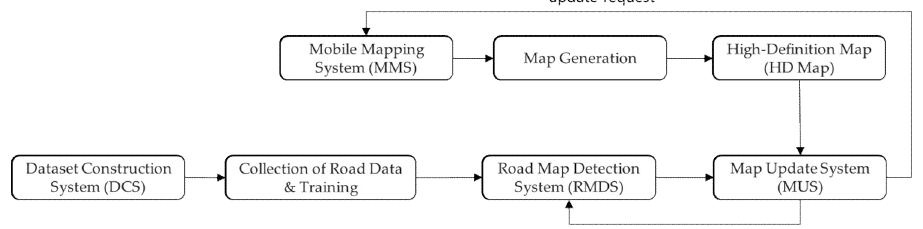
Figure 1. HD map generation and update scenario.